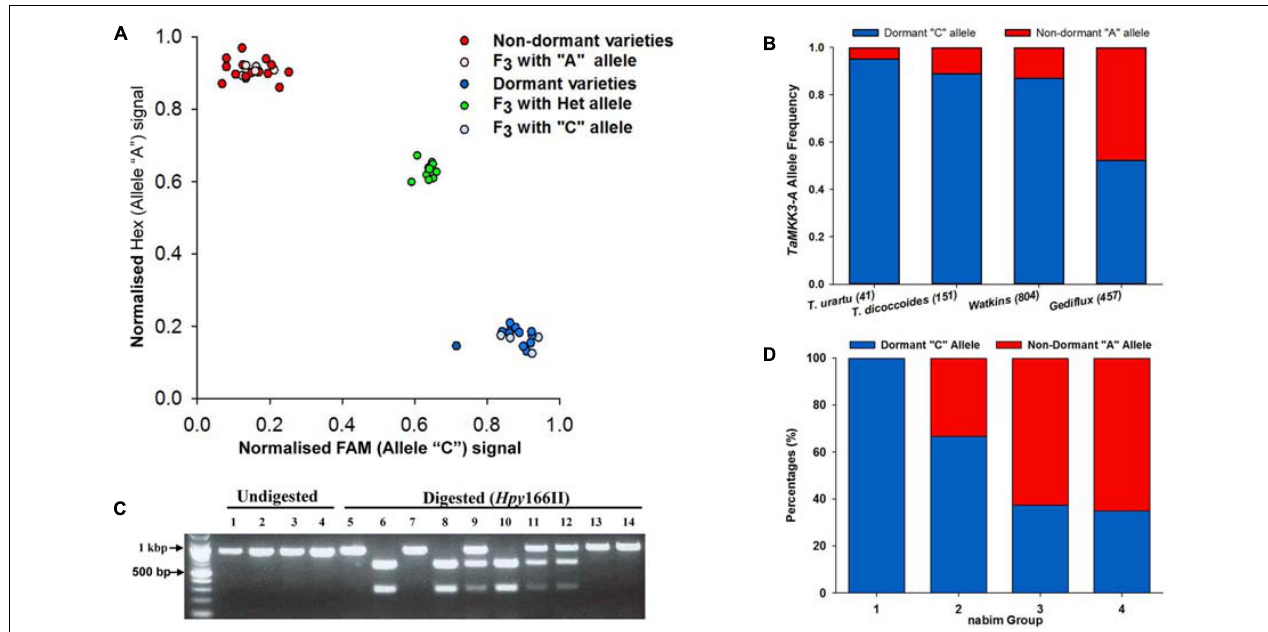
FIGURE 2 | Marker development and allele distribution of MKK3-A in ancestral and historic germplasm. (A) Genotype plot of varieties and a F 3 population segregating for Phs-A1 using the TaMKK3-A KASP assay. (B) Development of co-dominant CAPS marker based on Hpy 166II restriction digest of the C660A SNP. Lanes 1 - 4 contain undigested fragments of Robigus, Alchemy, Claire and Option, respectively, while Lanes 5 – 14 contain digested fragments of Robigus, Alchemy, Claire and Option (lanes 5–8) and six segregating F 3 plants from an Alchemy × Robigus cross (lanes 9–16). (C) Allele frequency of the causal C660A SNP in T. urartu and T. turgidum ssp. dicoccoides accessions and the Watkins and Gediflux collections. The number of lines genotyped in each germplasm set is in parenthesis. (D) TaMKK3-A allele distribution in the four wheat end-use groups (nabim 1–4) in the United Kingdom. The red and blue bars in (C,D) represents the non-dormant “A” allele” and dormant “C” allele,